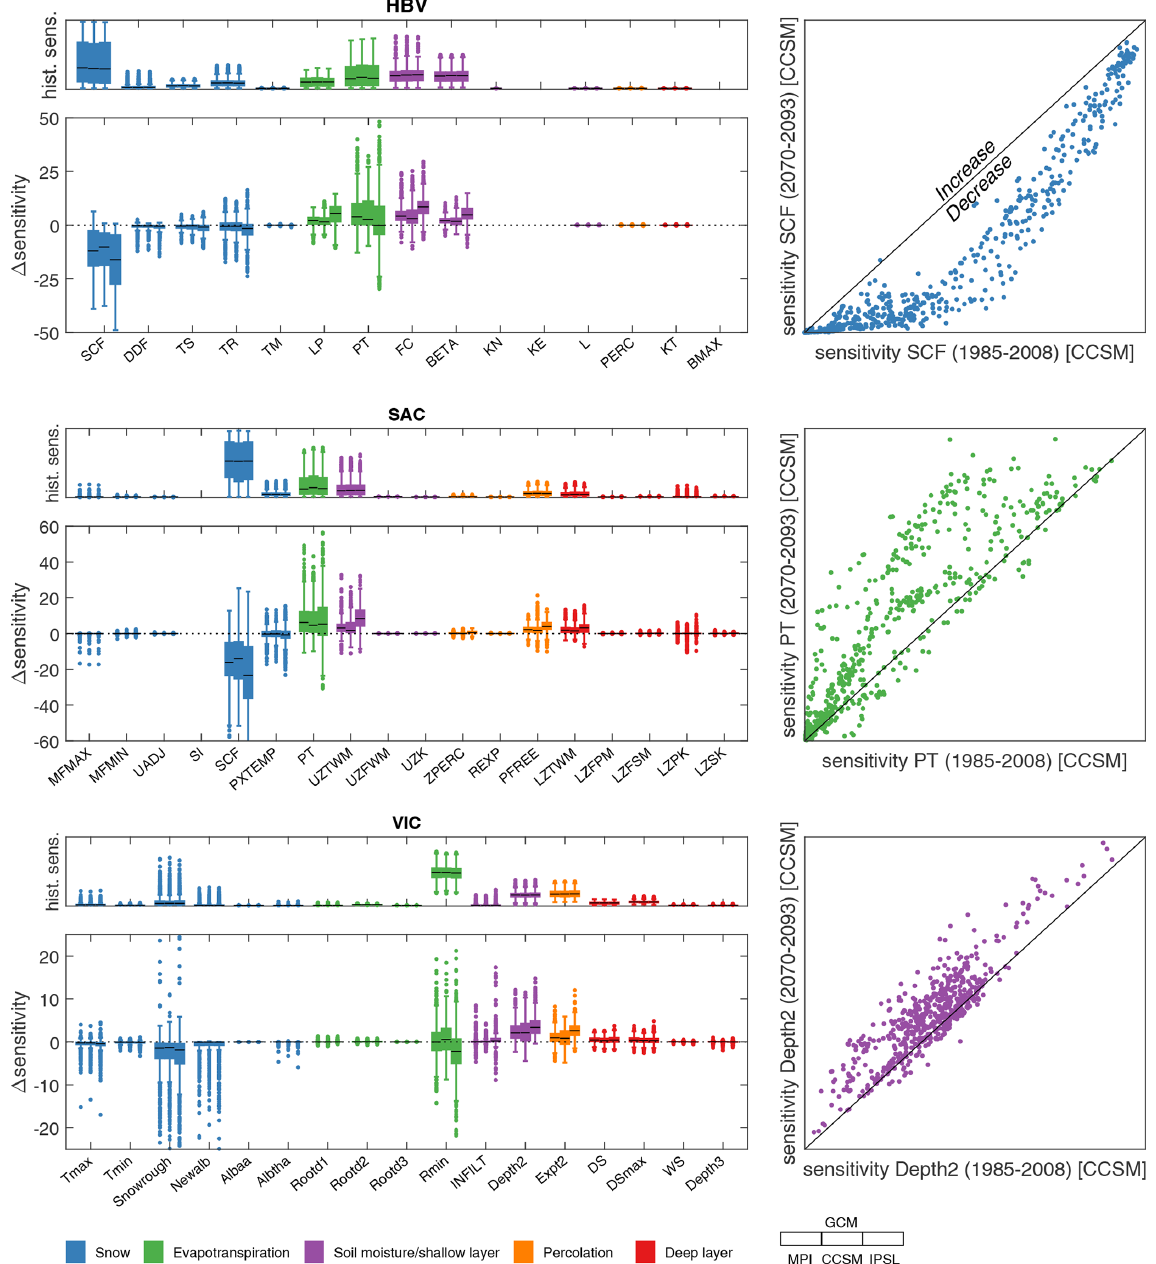
Figure 4. The distribution of change in parameter sensitivity ( (cid:49) sensitivity) over 605 basins for the period 2070–2093 compared to 1985– 2008, displayed per parameter per hydrological model, for three different GCM forcings. Above each (cid:49) sensitivity panel, historical sensitivity is displayed. The panels on the right show the data for a selected case per